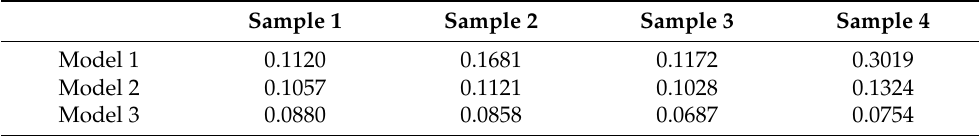
Figure 10. Comparison results of the three models and the real results: ( a ) sample 1; ( b ) sample 2; ( c ) sample 3; ( d ) sample 4. Table 8. Variance of the difference between the predicted value and real